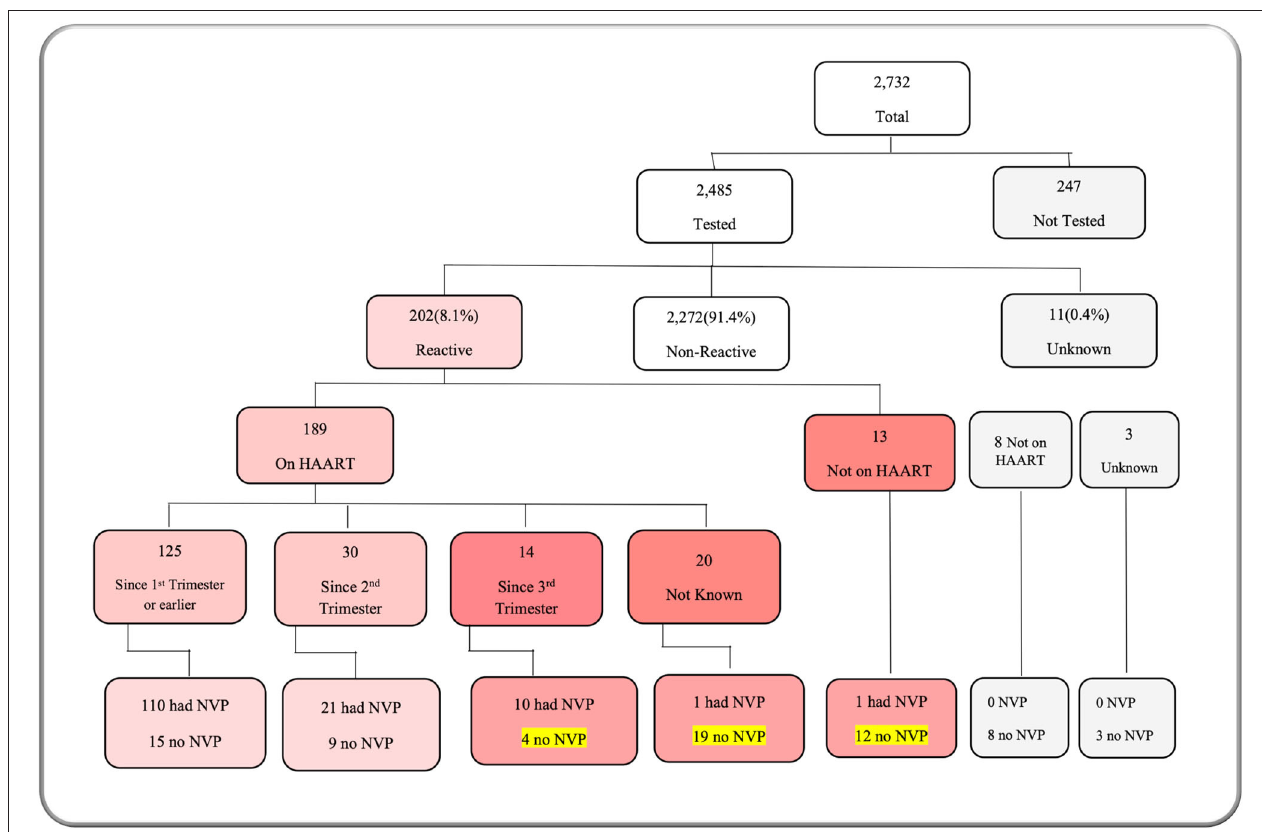
FIGURE 4 | M&M dashboard visual: maternal HIV status. HAART, human anti-retroviral therapy; NVP, nevirapine.